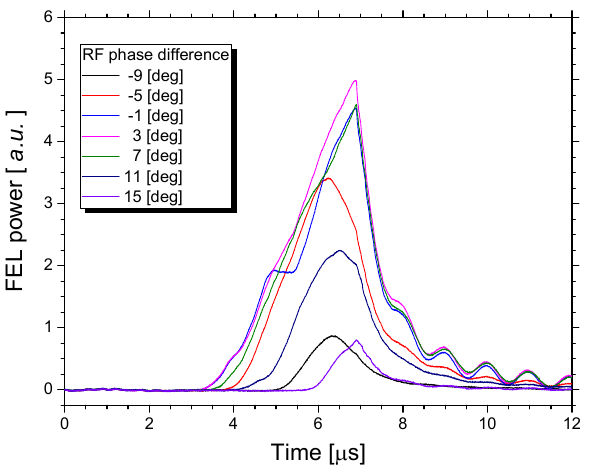
Figure 2. Relationship between the RF phase difference and the measured FEL macropulse.